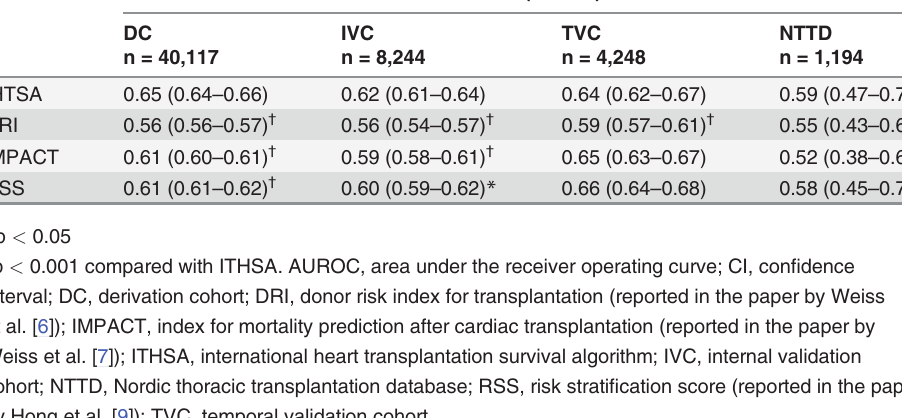
Table 6. Comparison of AUROCs between different risk models used to predict one- year mortality. AUROC (95% CI) DC